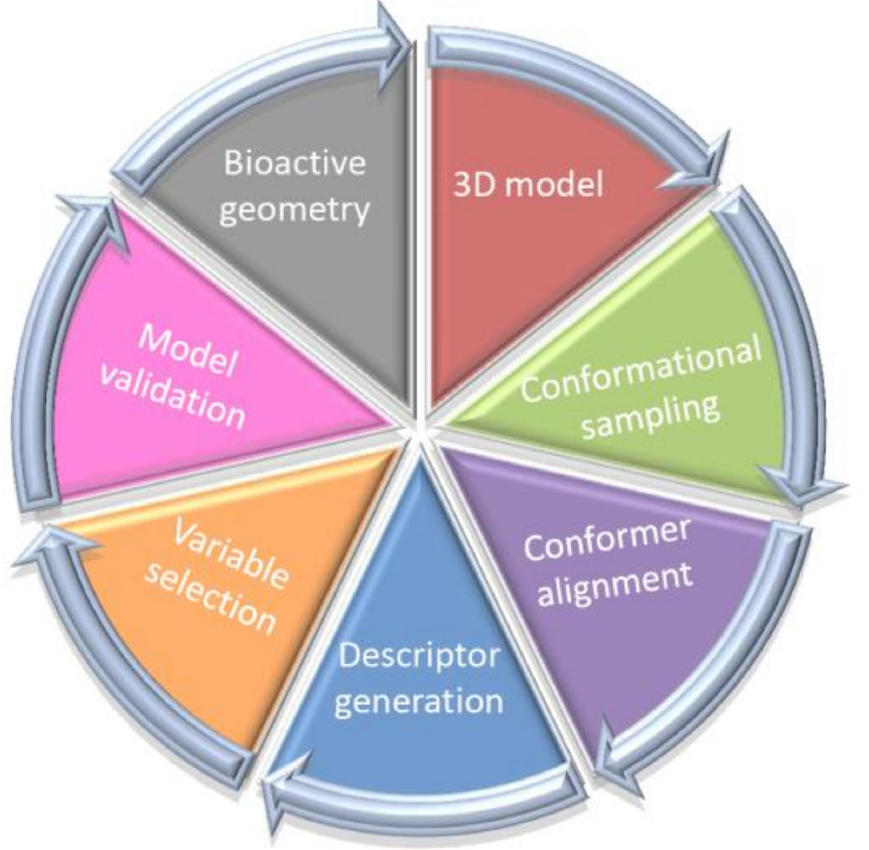
Figure 2. Multi-step 4D-QSAR